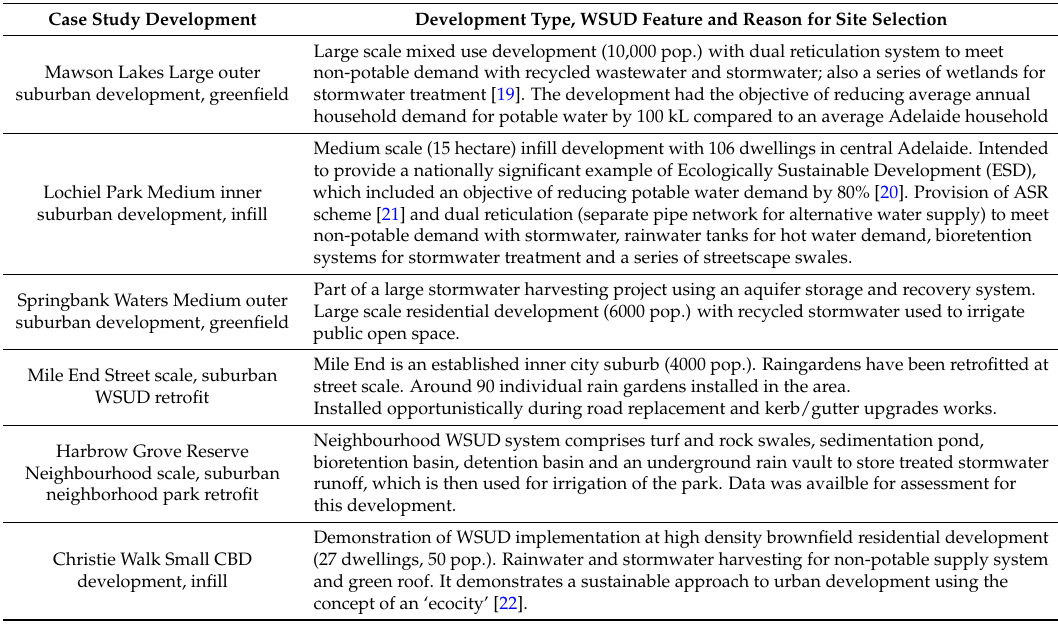
Table 3. WSUD sites for post implementation